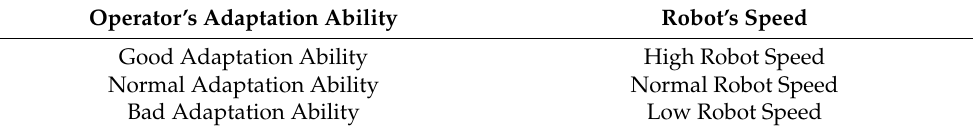
Figure 8. Robot Actions Depending on the Human Worker’s Intention. Table 3. Robot’s Decision Speed.